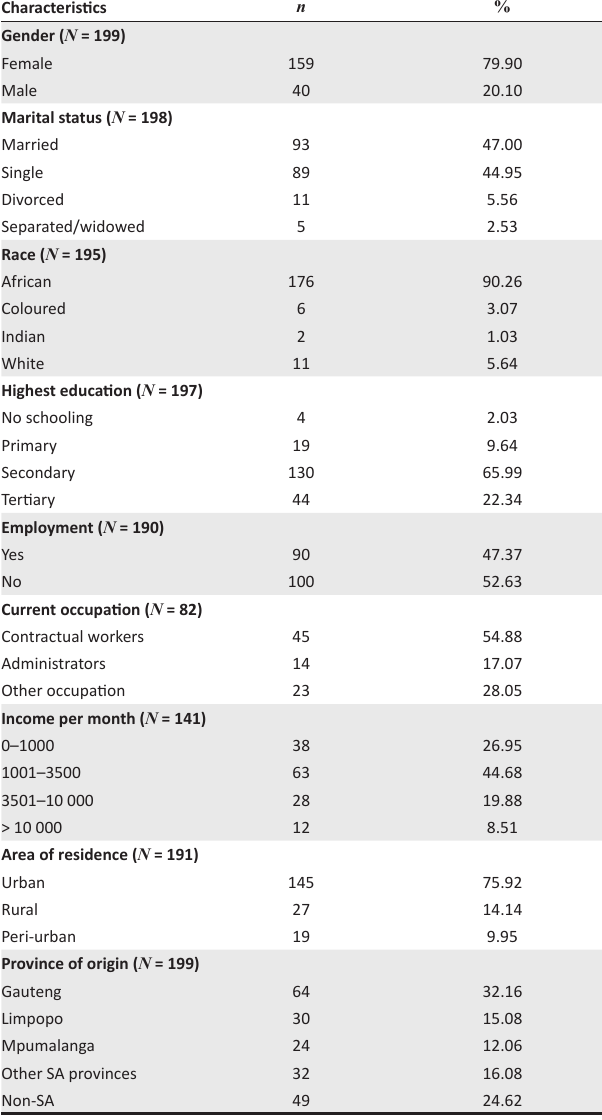
TABLE 1: Socio-demographic characteristics of participants. Characteristics